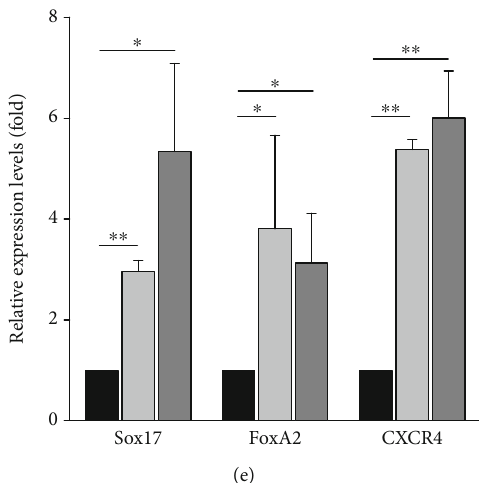
Figure 2: Comparison of small molecule combinations to induce cell di ff erentiation into a de fi nitive endoderm. (a) Mechanism of action of small molecules involved in IPC generation. (b) Cells cultured with activin A, LY294002, or CHIR99021 to induce di ff erentiation into a de fi nitive endoderm. (c) Immunostaining to detect FoxA2 in cells incubated with activin A, LY294002, and CHIR99021. (d) Abundant CXCR4 expression in cells incubated with activin A and CHIR99021, activin A, LY294002, and CHIR99021. (e) Quantitative PCR fi ndings show the most abundant expression of Sox17 and CXCR4 mRNA, but relatively lower expression of FoxA2 mRNA in cells incubated with activin A, LY294002, and CHIR99021, than in those incubated with activin A and CHIR99021. Bars: means ± standard deviation ( n = 3 ). ∗ P < 0 : 05 , ∗∗ P < 0 : 005